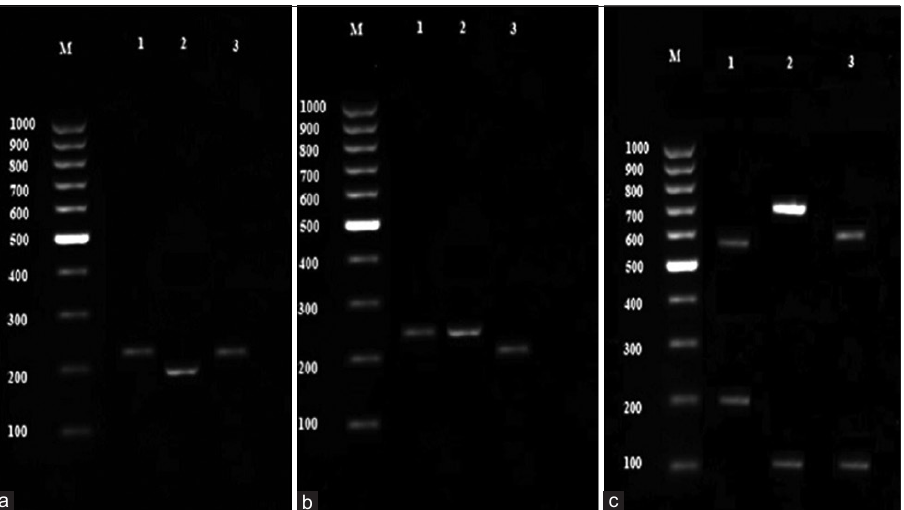
Figure-3: (a) Restriction fragment length polymorphism (RFLP) pattern result of 3´SAG2 gene: M – 100 bp marker, 1 - Genotype I, 2 - Genotype II, 3 - Genotype III. (b) RFLP pattern result of 5´SAG2 gene: M – 100 bp marker, 1 - Genotype I, 2 - Genotype II, 3 - Genotype III. (c) RFLP pattern result of GRA6 gene: M – 100 bp marker, 1 - Genotype I, 2 - Genotype II, 3 - Genotype